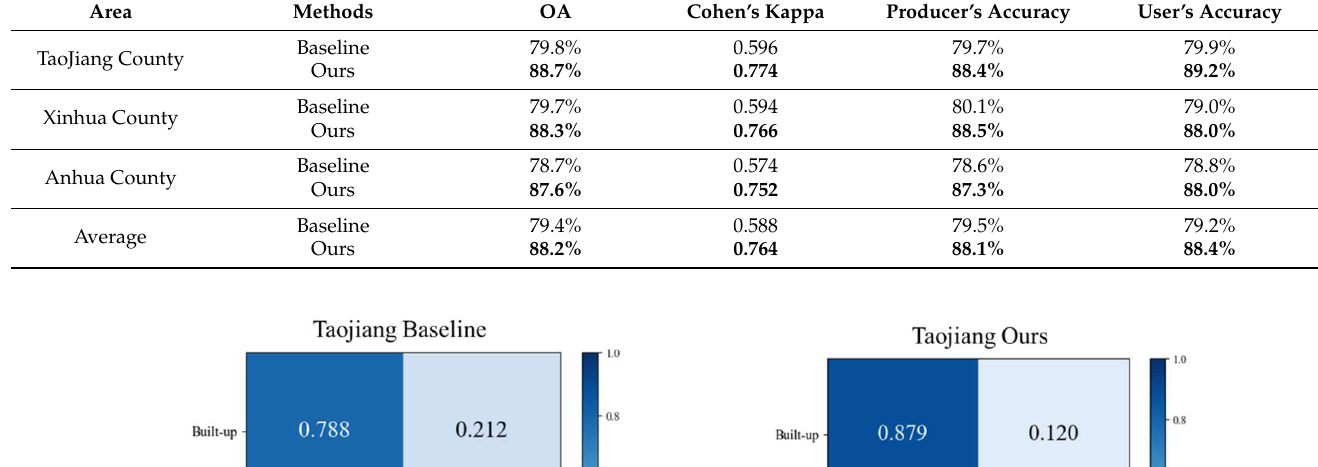
Table 3. Results in Taojiang County, Xinhua County and Anhua County.